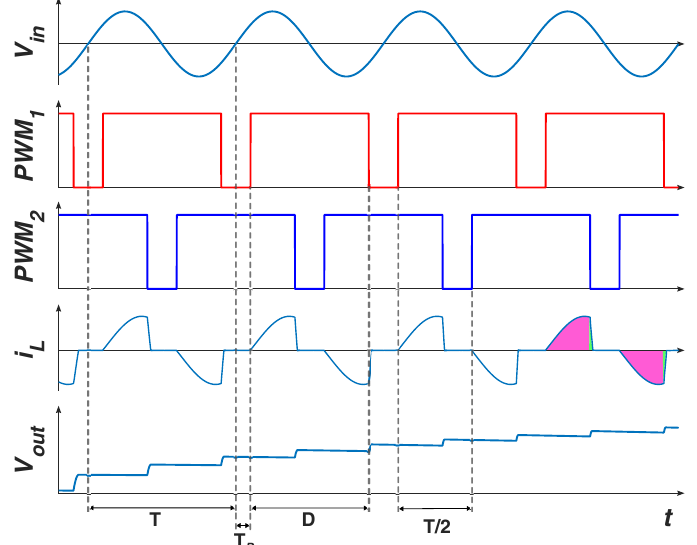
Figure 4. Qualitative trends of main electrical quantities involved in a AC–DC boost converter in Discontinuous current Conduction Mode (DCM). Magenta color represents the positive or negative inductor charging phase, while the green one is the discharging phase on the output load.